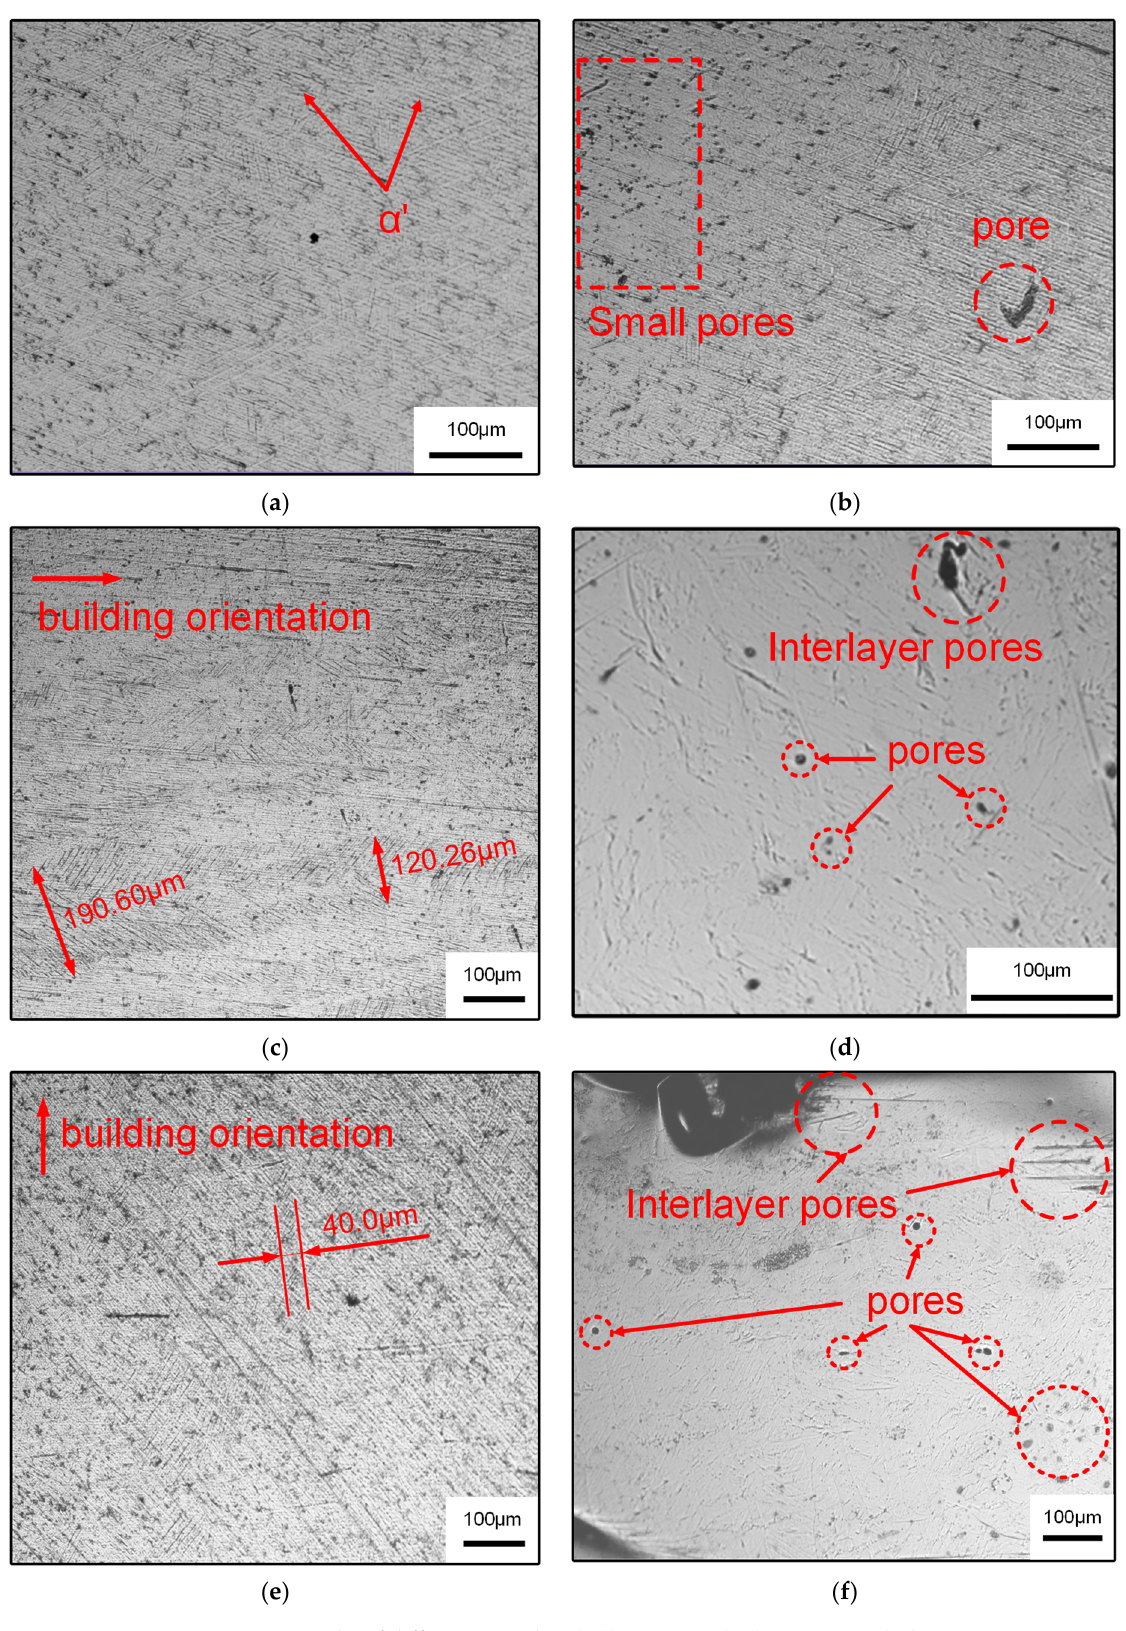
Figure 4. OM micrographs of different samples. ( a , b ) SLM-VB; ( c , d ) SLM-PB-S; ( e , f ) SLM-PB-L.